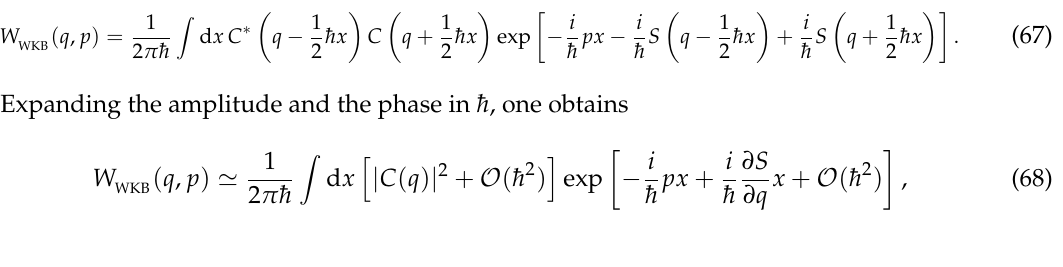
Figure 3. Wigner function (63) for the Schrödinger cat state (60). The two bumps correspond to ( q , p ) in Equation (63) and would be the Wigner function if the state was given by Φ W ± The oscillations in between correspond to W int ( q , p ) in Equation (63) and are present because of the superposition of the two wavepackets. In this region, it is obvious from the figure that the Wigner function can be negative. Thus, the superposition of two wavepackets, a genuine quantum effect, is associated with region in phase space, where the Wigner function can take negative values. We have used q 0 = 6, p 0 = 0 and m = ω =